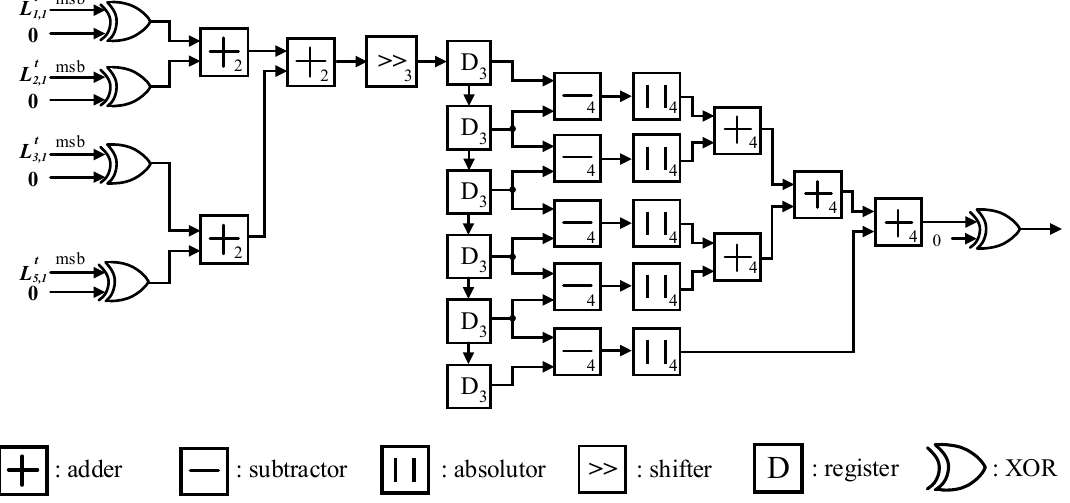
Figure 5. Hardware architecture of frozen-BER-based early termination method [17] of (8, 4) polar codes. Algorithm 4: Proposed early-termination technique